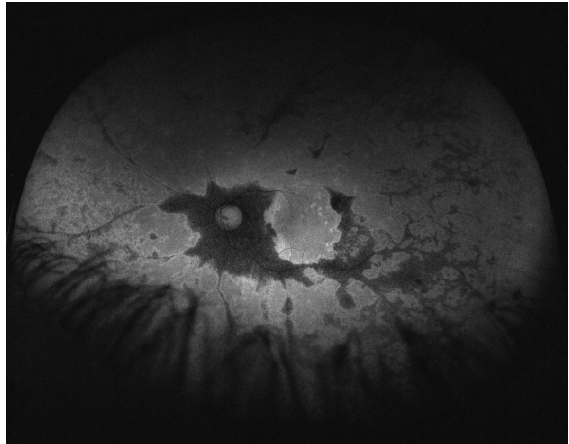
Figure 2: Autofluorescence image of the left eye demostrating hypoautofluorescence at the paravenous zone